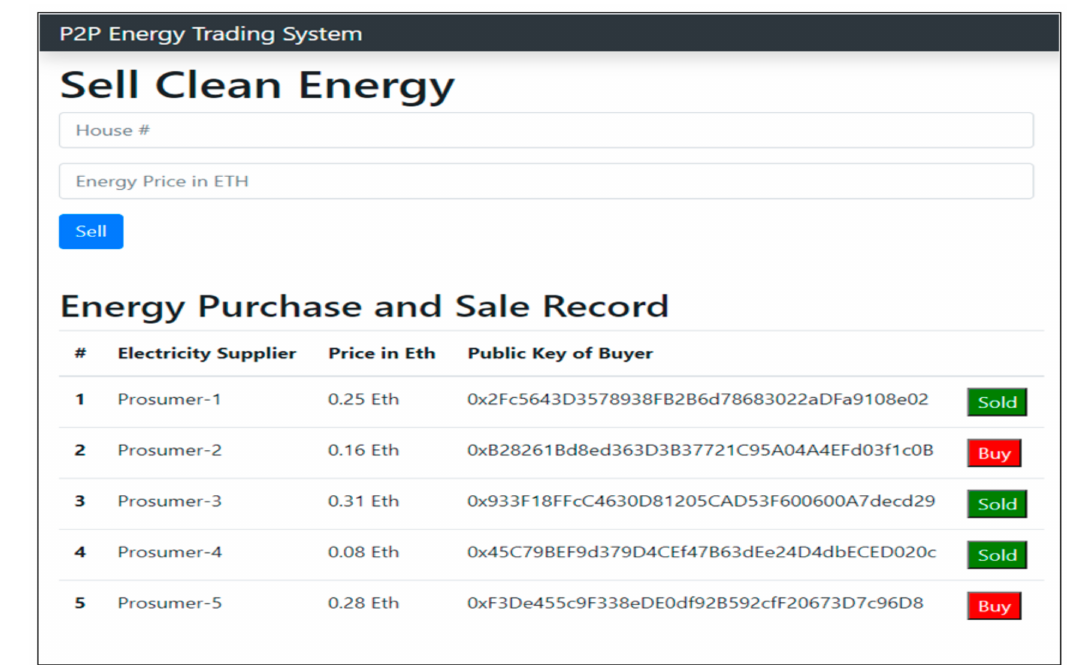
Figure 15. Energy transaction record in the web app.